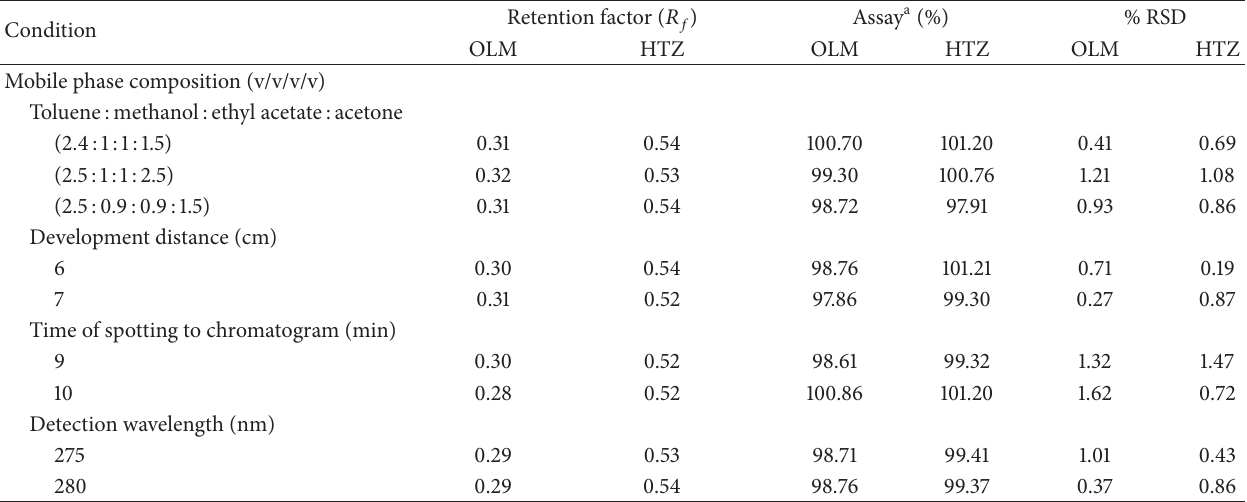
Table 4: Results from robustness study.